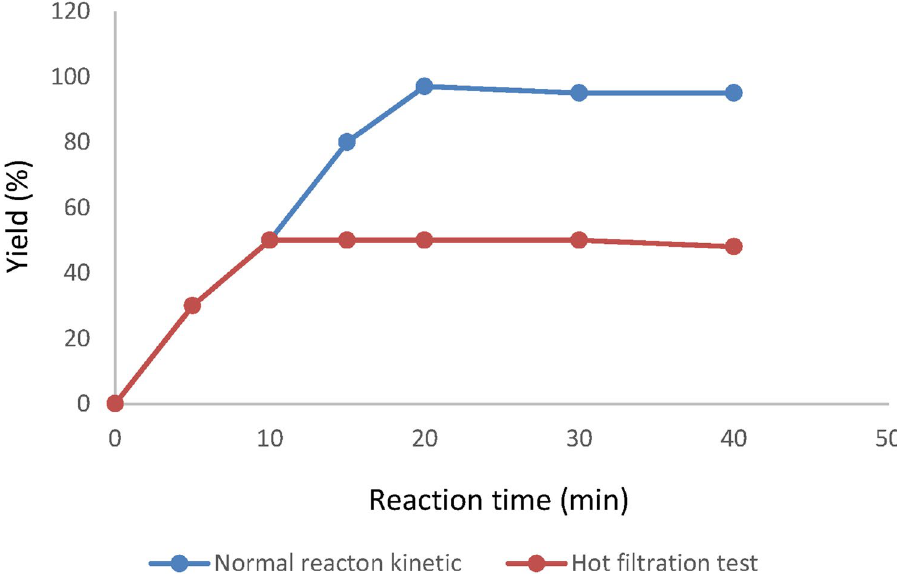
Figure 17. Hot filtration diagram of Fe 3 O 4 @SiO 2 -Im[Br]-SB-Cu (II) nano-catalyst in the synthesis reaction of tetrazole derivatives.